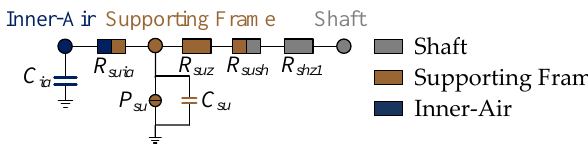
Figure 8. The thermal model of the support frame.